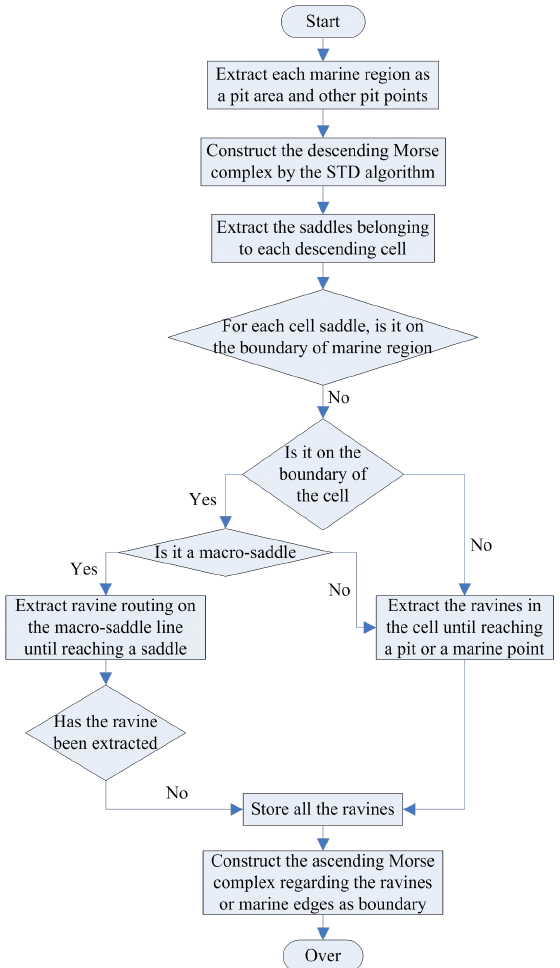
Figure 4. The flow chart of constructing the original